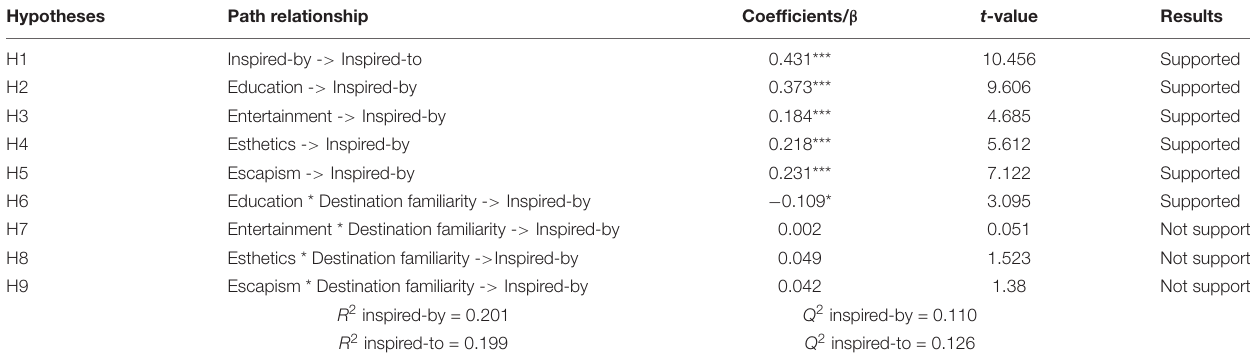
TABLE 5 | Path analysis.